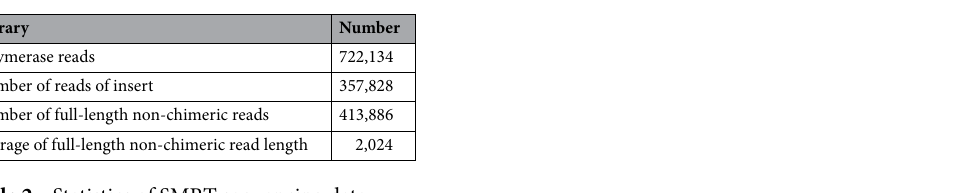
Table 2. Statistics of SMRT sequencing